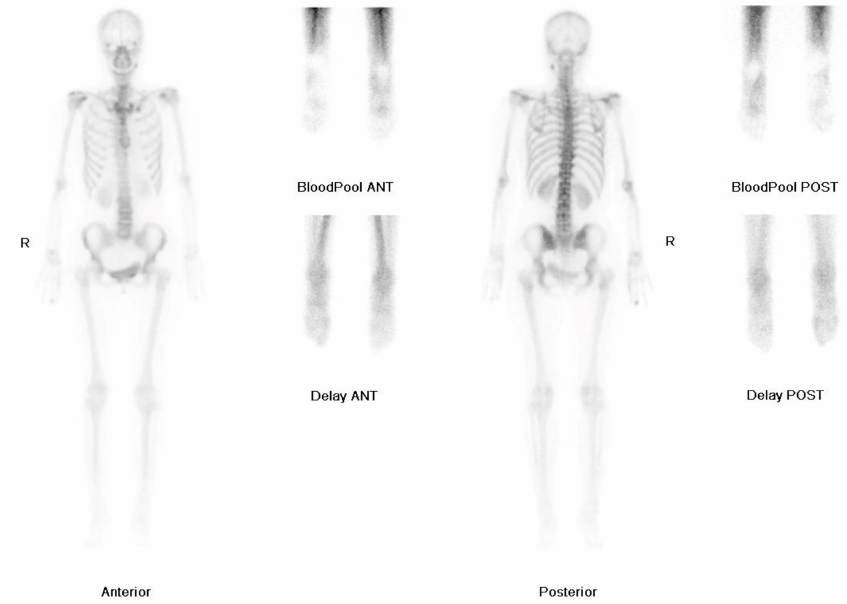
Figure 3. Three-phase bone scan: Decreased uptake in the right foot during the blood pooling phase and mildly increased uptake in the right first toe during the osseous